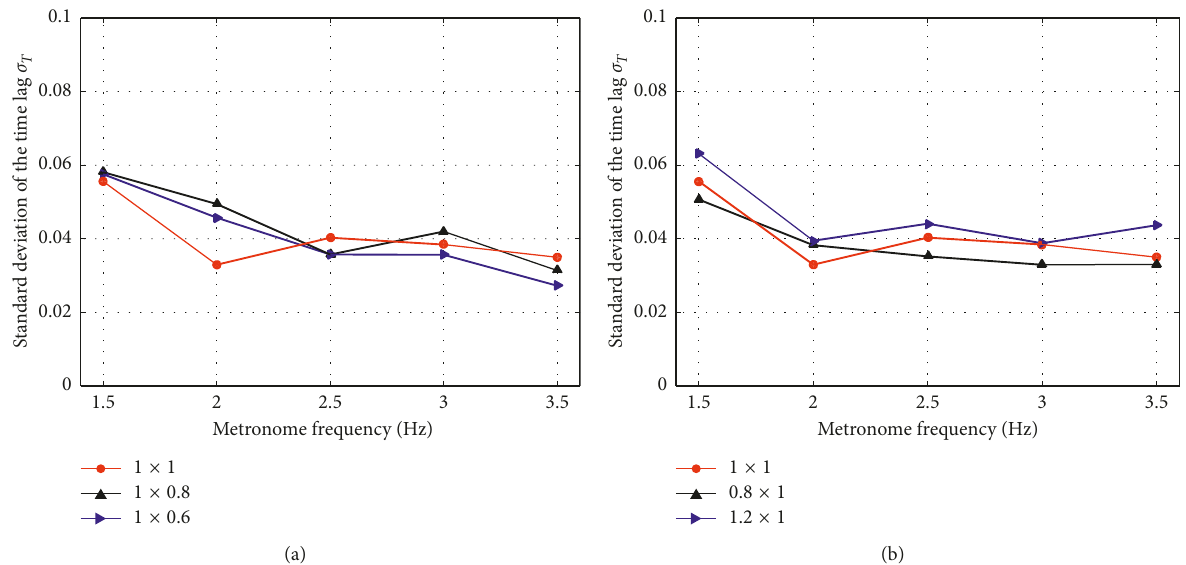
Figure 28: Comparison of the time lags with three configurations in two groups. (a) Time lags in group 01; (b) time lags in group 02.